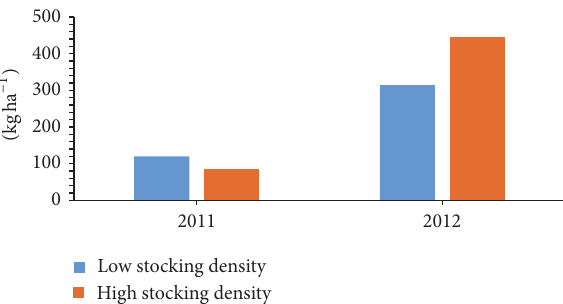
Figure 6: Productivity (kgha −1 ) by stocking density, during winter grazing over two